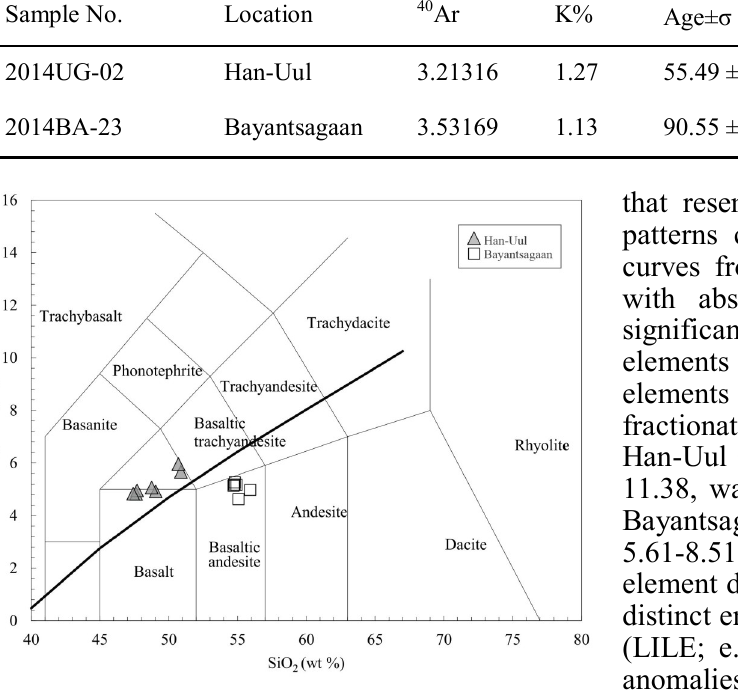
O+K O) versus SiO (Le Bas et al., 2 2 2